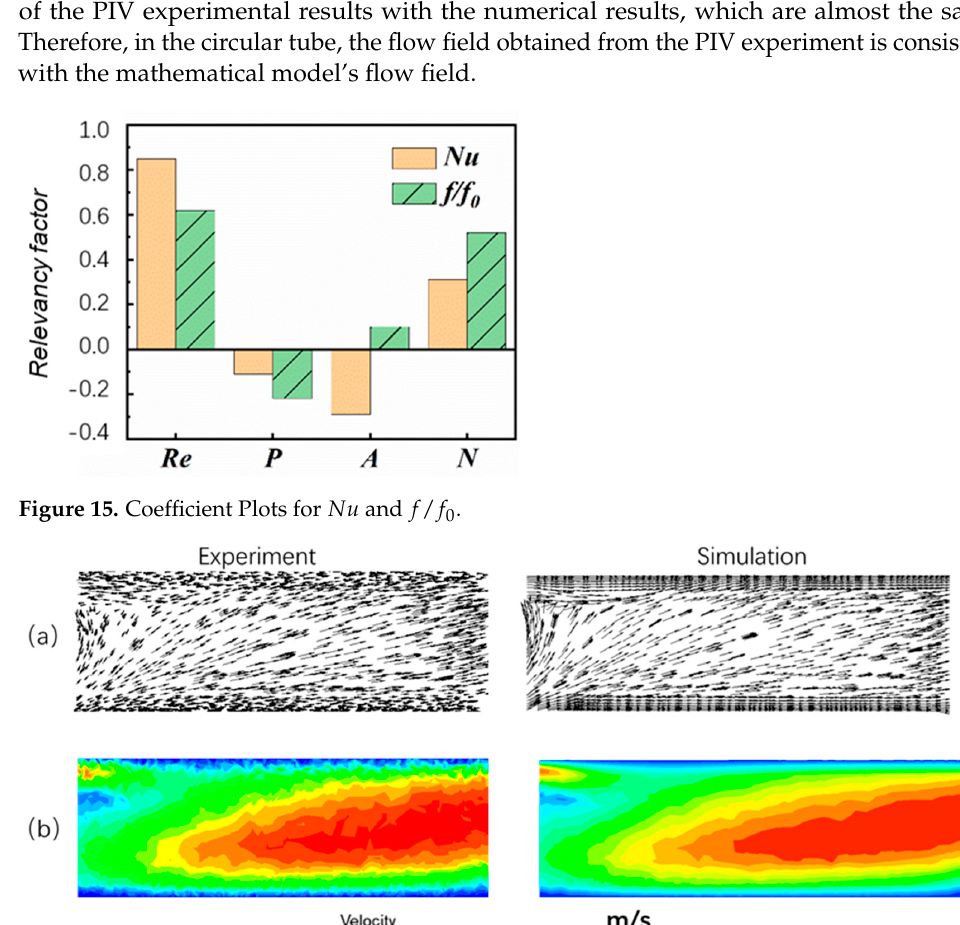
Figure 16. Schematic diagram of flow fields in a circular tube tested by a PIV experiment and sim- lulation at 𝑹𝒆 = 400, N = 4, A = 45°, p = 4 mm:( a)Vectors maps,(b) Velocity contour. simlulation at Re = 400, N = 4, A = 45 ◦ , p = 4 mm: ( a ) Vectors maps, ( b ) Velocity